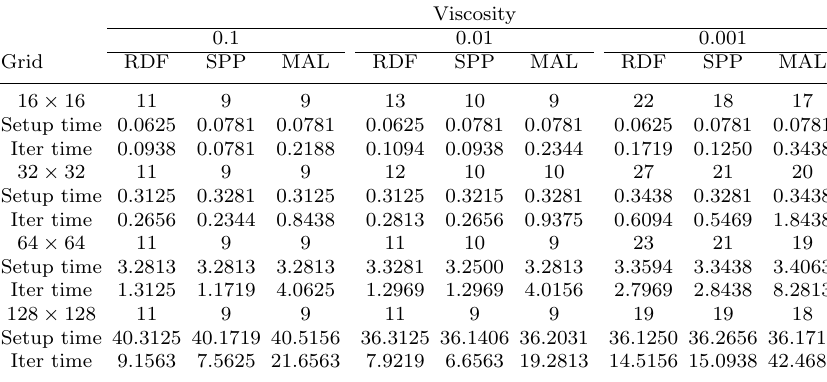
Table 1. Number of GMRES(20) iterations and timings with the RDF, MAL and SPP pre- conditioners for steady Oseen problem (Q2-Q1 FEM uniform grids), the optimal parameters values of τ , α , γ are respectively found experimentally.